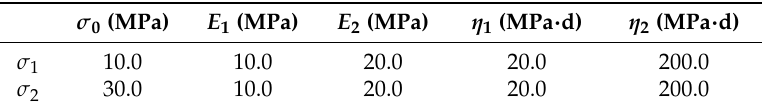
Figure 10. Comparison of creep strains between single-step loading and multi-step loading for the Burgers model. Table 4. Parameters of the Burgers